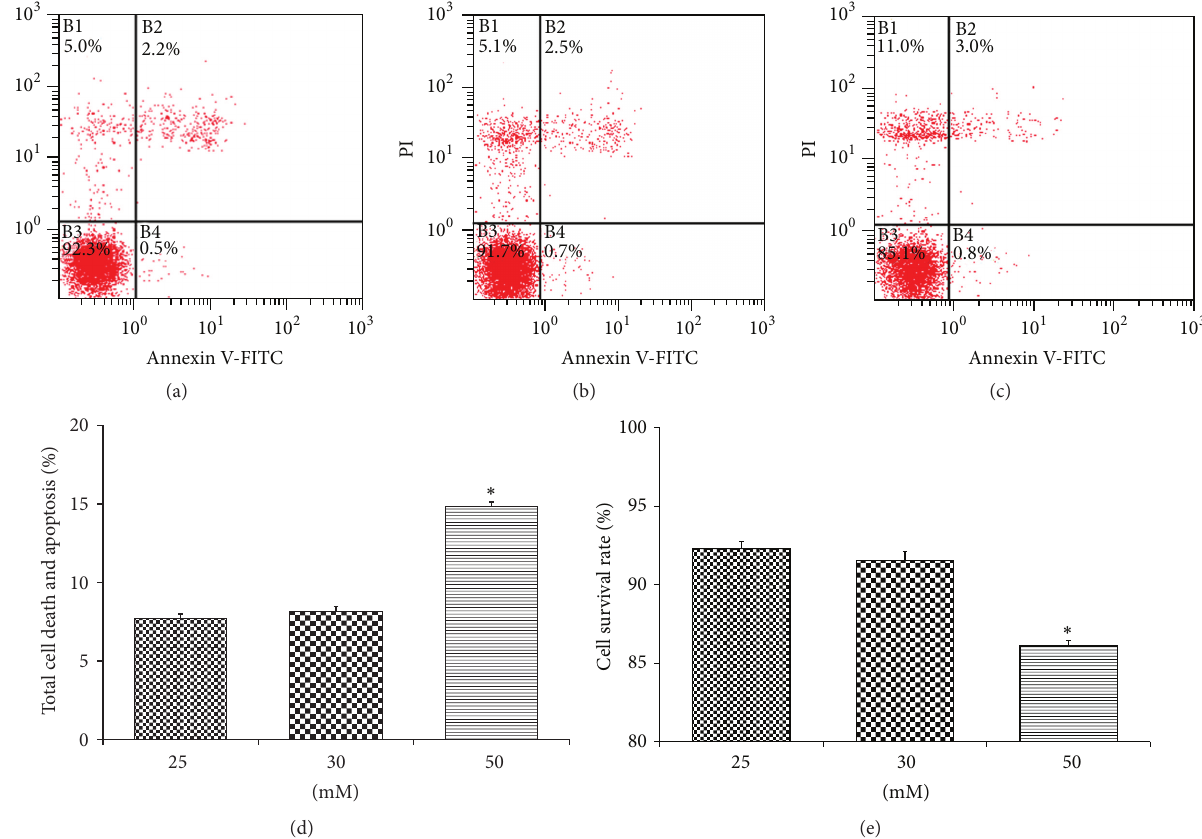
Figure3:Flowcytometricanalysisofapoptoticanddeadcellsafter24 hofglucosestimulationincontrolgroup(a),30mMglucosestimulation group (b), and 50 mM glucose stimulation group (c) represented as apoptotic and dead cells (d) and viable cells (e). Results showed a significantly higher apoptotic activity and lower survival rate in high glucose group ( 𝑃 < 0.05